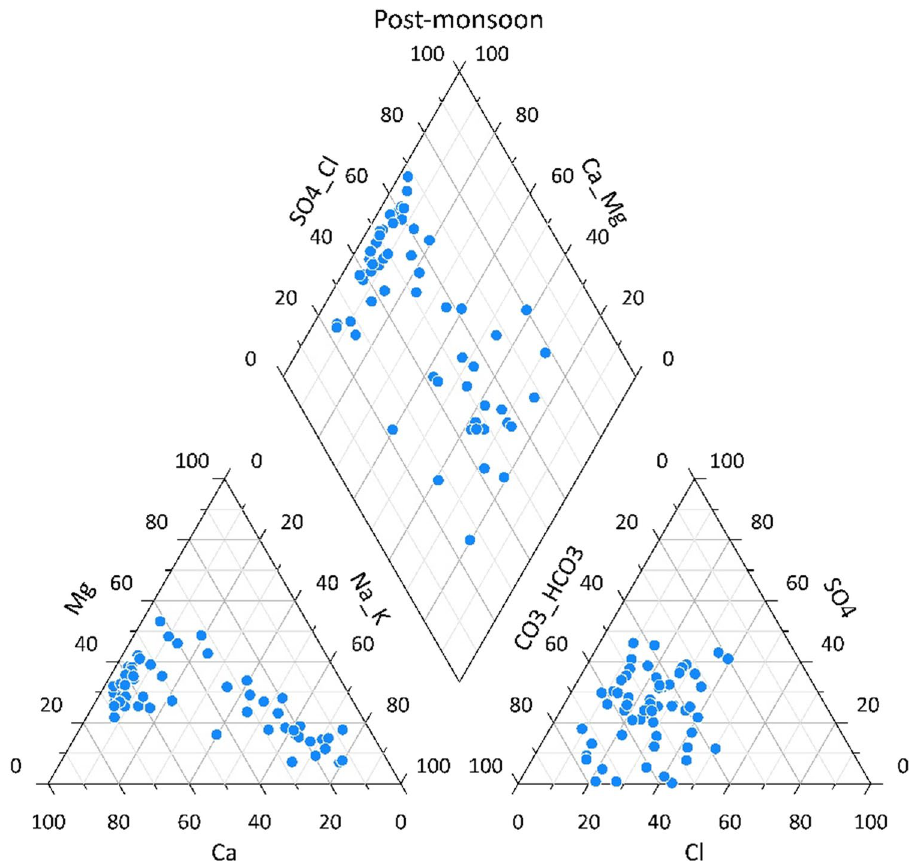
Fig. 2 Piper plot for groundwa- ter samples showing water type from the study